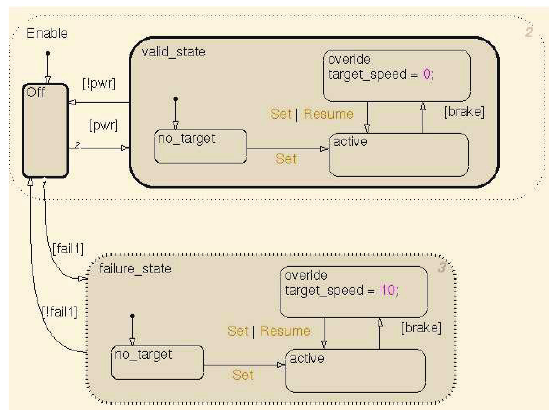
Fig. 8. Simulink Stateflow model (including failure) active proctype nondeterm(){